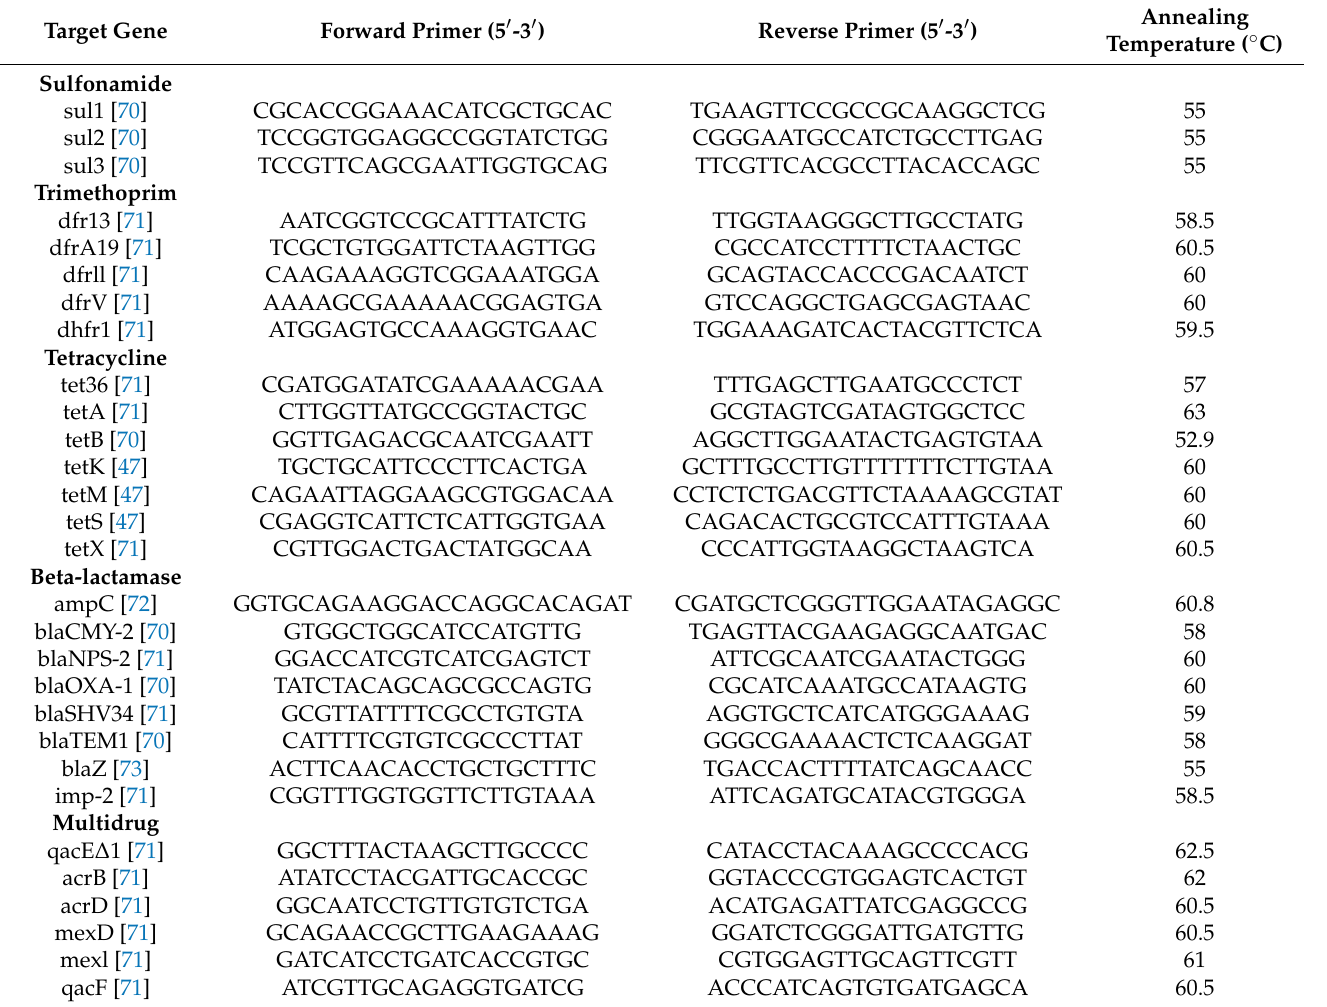
Table A2. The sequence and annealing temperature of the primers of the 29 ARGs quantified in this study.